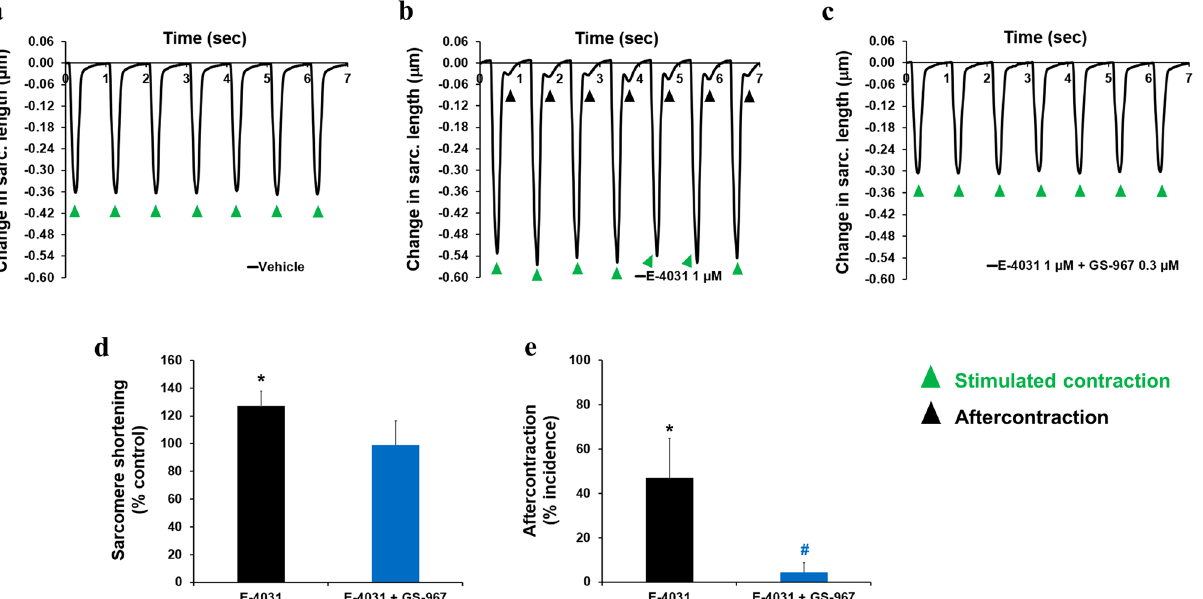
Figure 8. Effects of GS-967 on human ventricular contractility in condition mimicking LQTS2. ( a – c ) show typical contractility transients recorded from a ventricular cell at a pacing of 1 Hz in the presence of vehicle control ( a ) and after exposure to 1 µM E-4031 alone ( b ) or in combination with 0.3 µM GS-967 ( c ). ( d ) and ( e ) show mean % change in sarcomere shortening ( d ) and mean % incidence of aftercontraction and contraction failure ( e ) when cardiomyocytes were treated with 1 µM E-4031 alone or in combination with 0.3 µM GS-967 (n = 8 cells) at 1 Hz. * p < 0.05 versus values from vehicle control. # p < 0.05 versus values from E-4031. IonWizard